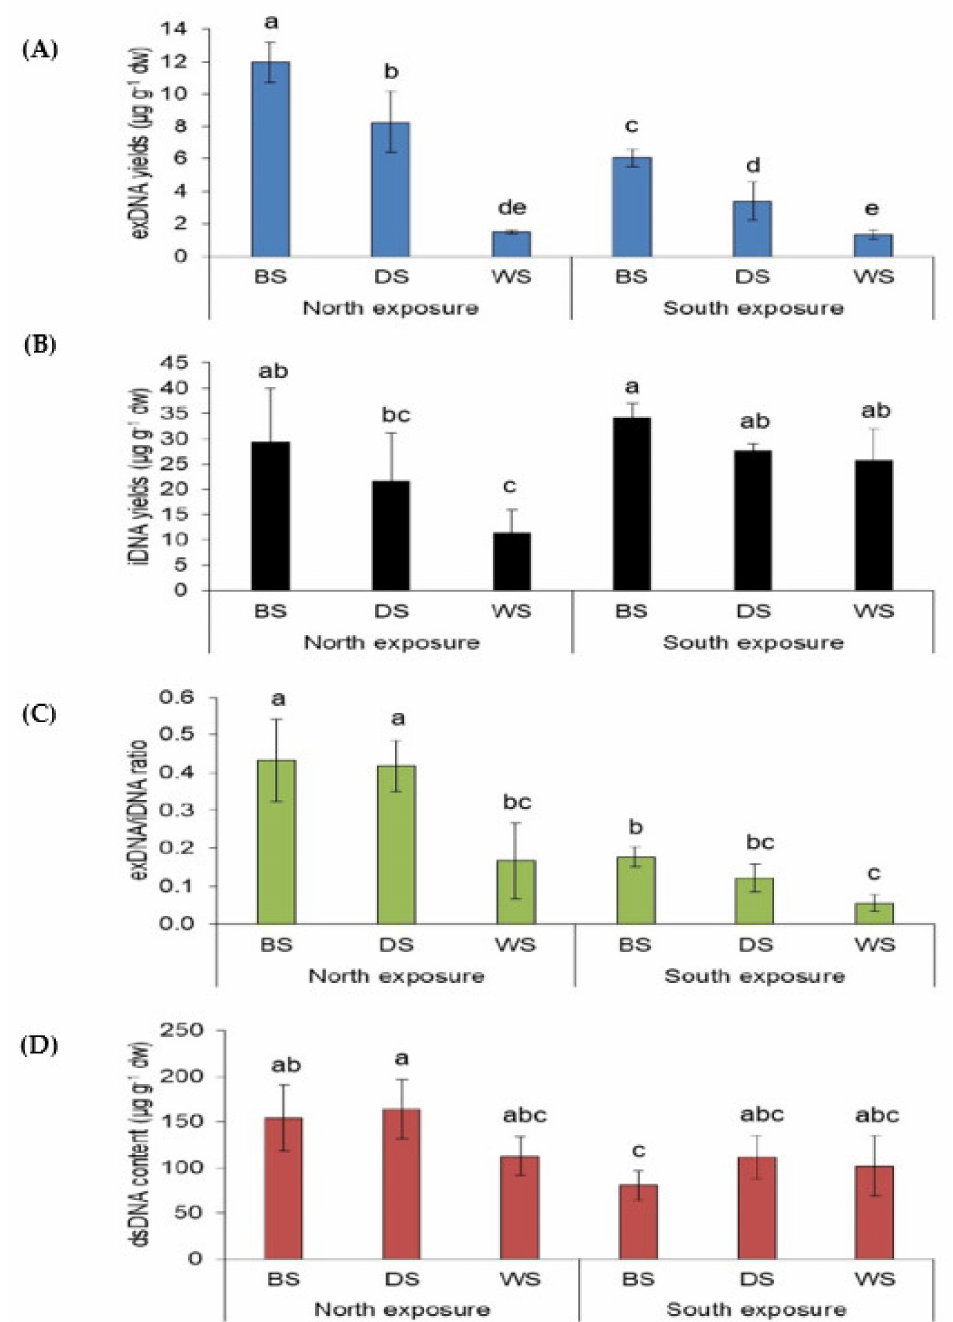
Figure 2. Yields of sequentially extracted extracellular DNA (exDNA; ( A )), intracellular DNA (iDNA; ( B )), and exDNA/iDNA ratio ( C ), and directly extracted double-stranded total DNA (dsDNA; ( D )) in the bulk soil and the aggregate size fractions in the organic (OF) horizon at the north- and the south-facing sites. Values are mean values ± standard deviation. Different letters indicate significant differences ( p < 0.05; ANOVA followed by Duncan post-hoc test) regarding the bulk soil (BS), and the dry-sieved (DS) and wet-sieved water-stable (WS) 1.00–0.50 mm